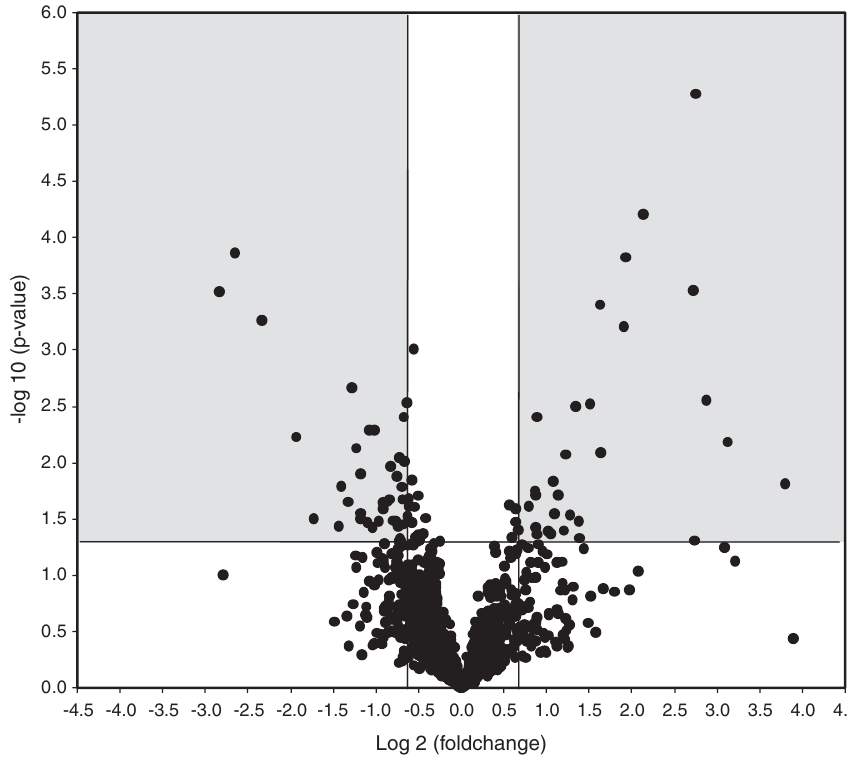
Fig. 2. Selection of leptin-regulated protein spots. Volcano plot showing the selection of the spots based on >1.5 mean fold change (vertical lines) and p -value<0.05 (horizontal line). Spots that passed the criteria fall within the shaded